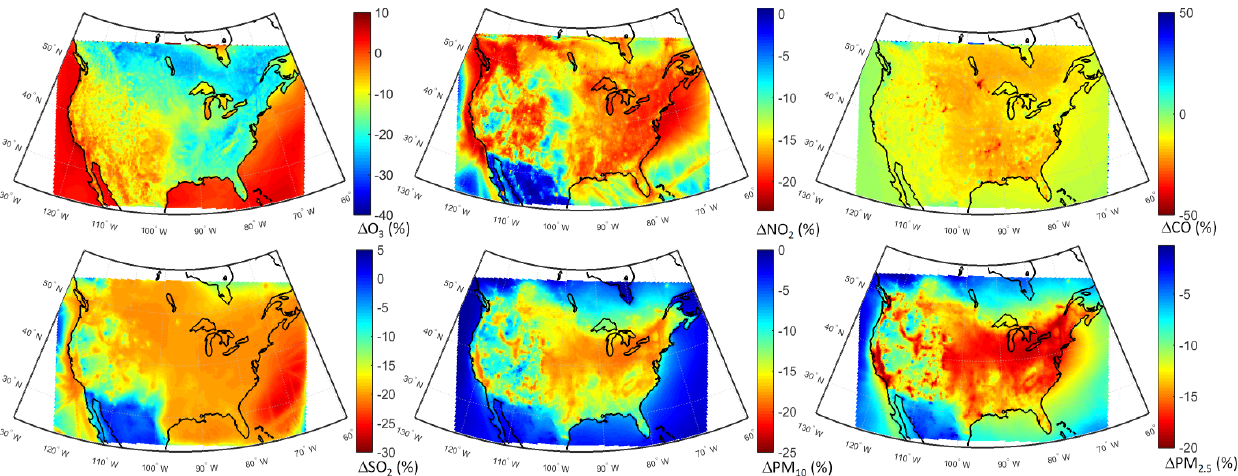
Figure 12. Spatial distribution of the annual mean relative differences between the North American emission perturbation scenario and the base case over North America as simulated by the multi-model mean